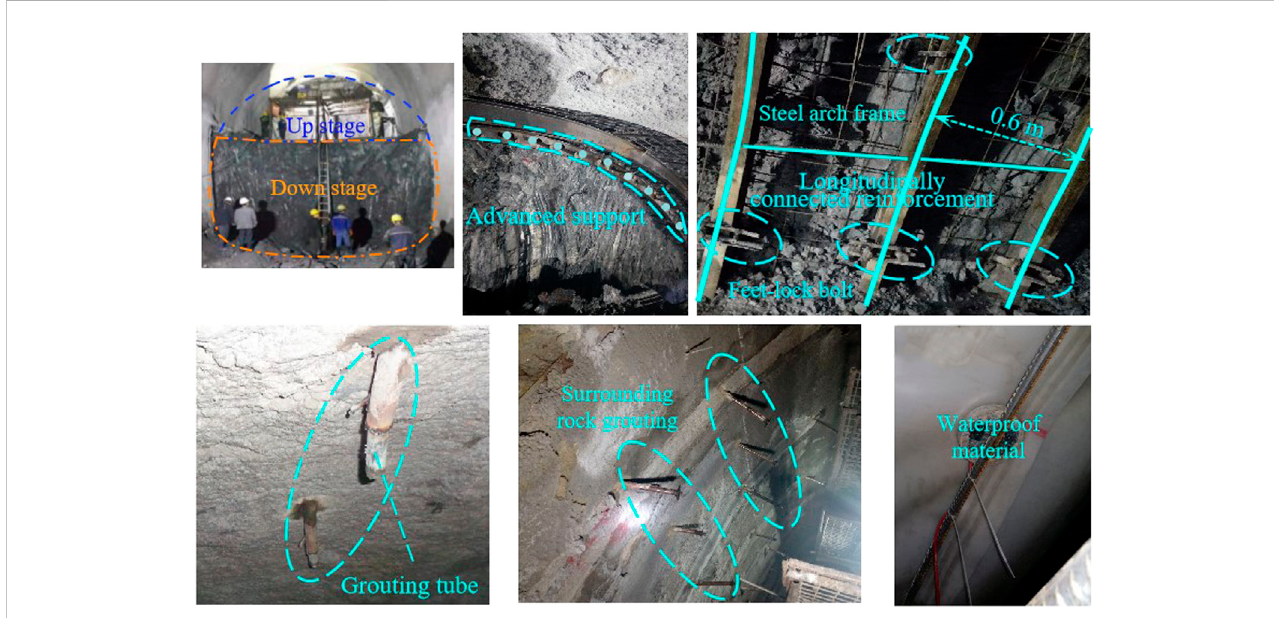
FIGURE 3 Field application of improved construction measures.